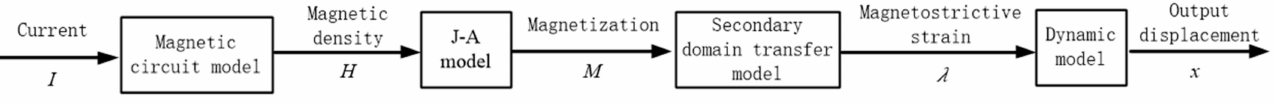
Figure 2. Modeling flow chart.